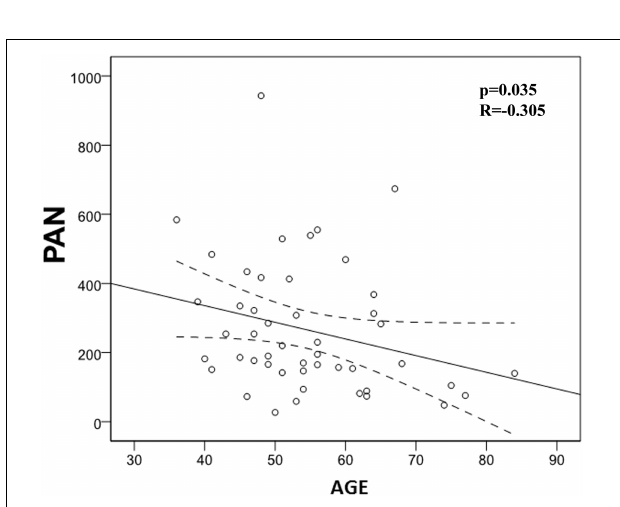
FIGURE 6 | Correlation between phagocytic activity of neutrophils (PAN) and age ( p = 0.035; R = -0.305). There is a significant negative correlation between PAN and age. TABLE 7 | Correlation between stress and NCI in both sexes. Correlation